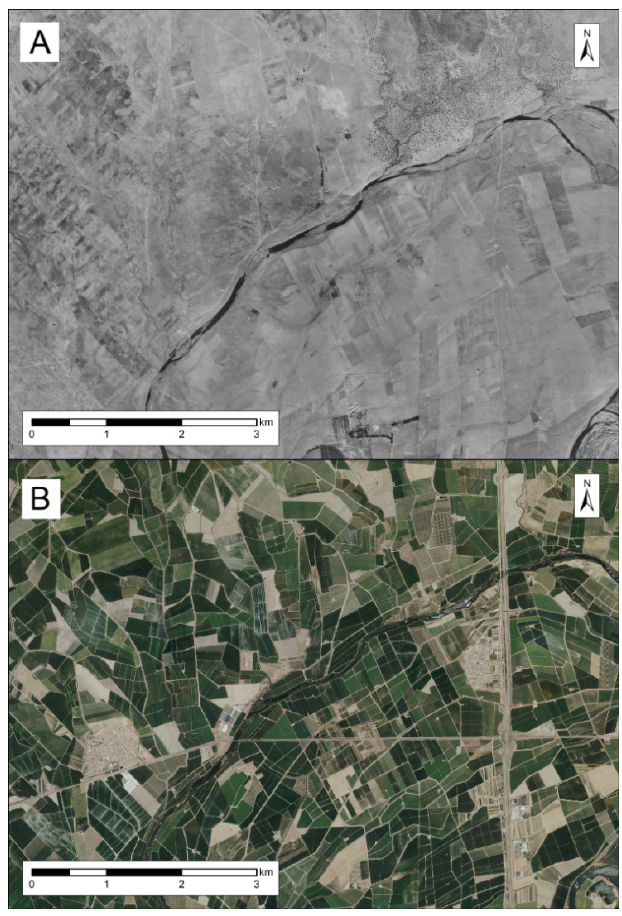
Figure 2. Aerial photographs of the section of the Guadiana between the Búrdalo and Ruecas tributaries showing the impact on the landscape caused by the implementation of the Badajoz Plan. ( A ) Photograph from the American flight of 1945/1946. ( B ) Still from the PNOA Máxima Actualidad .